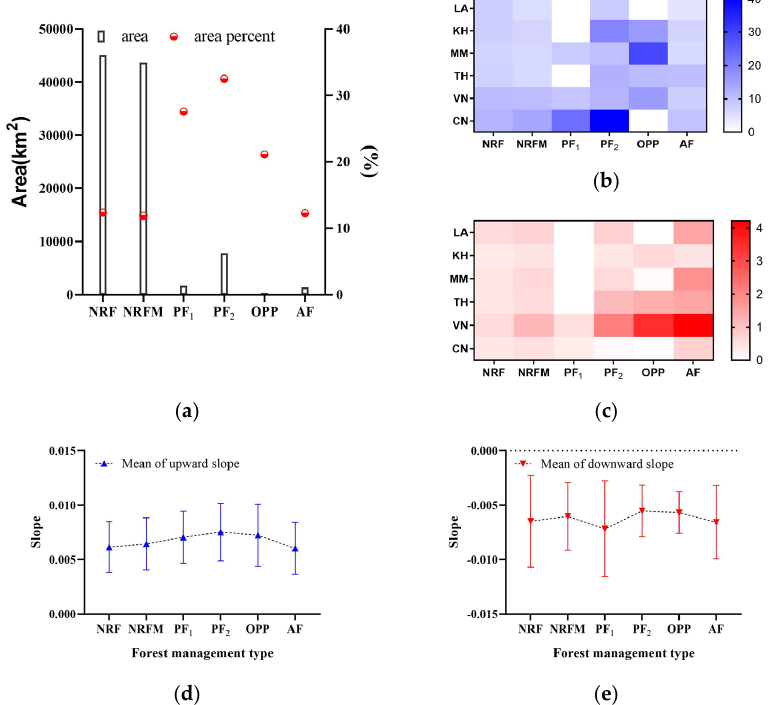
Figure 7. Trends in EVI for different forest management types: ( a ) area distribution of significant trends in EVI in forest management types; ( b , c ) proportion of upward and downward trends in EVI for forest management classes; ( d , e ) significant slope in EVI for forest management types.